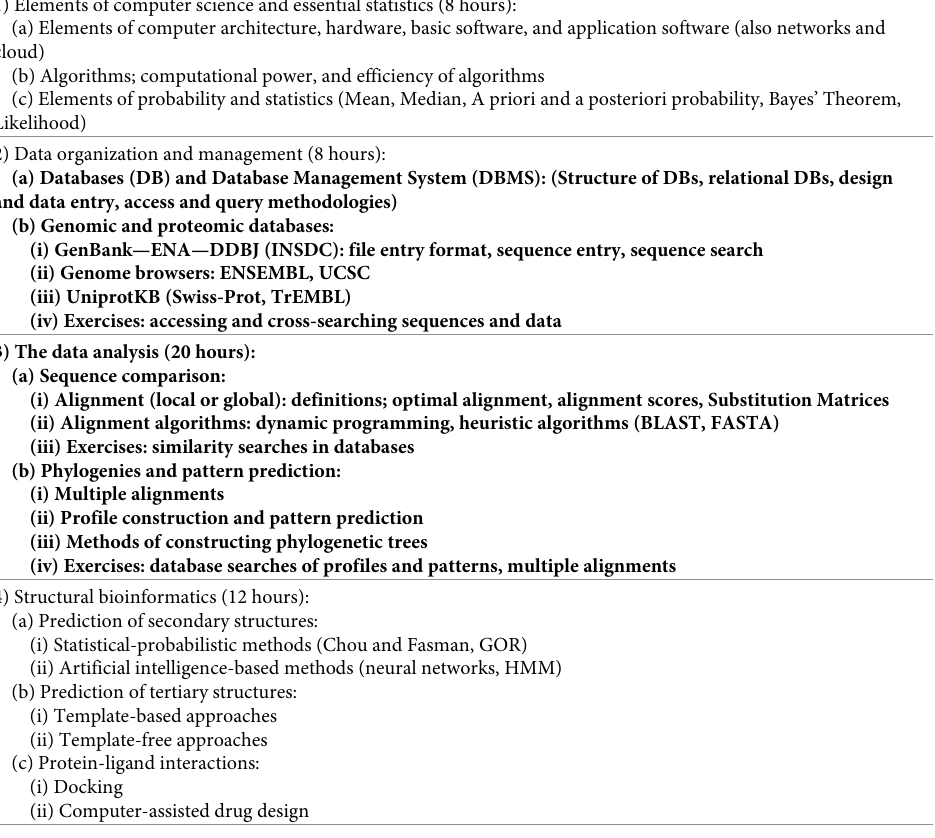
Table 2. Recommended contents for bioinformatics courses embedded in a study path belonging to a BSc degree in life science and medicine scientific area. 1) Elements of computer science and essential statistics (8 hours): (a) Elements of computer architecture, hardware, basic software, and application software (also networks and cloud) (b) Algorithms; computational power, and efficiency of algorithms (c) Elements of probability and statistics (Mean, Median, A priori and a posteriori probability, Bayes’ Theorem, Likelihood) 2) Data organization and management (8 hours): (a) Databases (DB) and Database Management System (DBMS): (Structure of DBs, relational DBs, design and data entry, access and query methodologies) (b) Genomic and proteomic